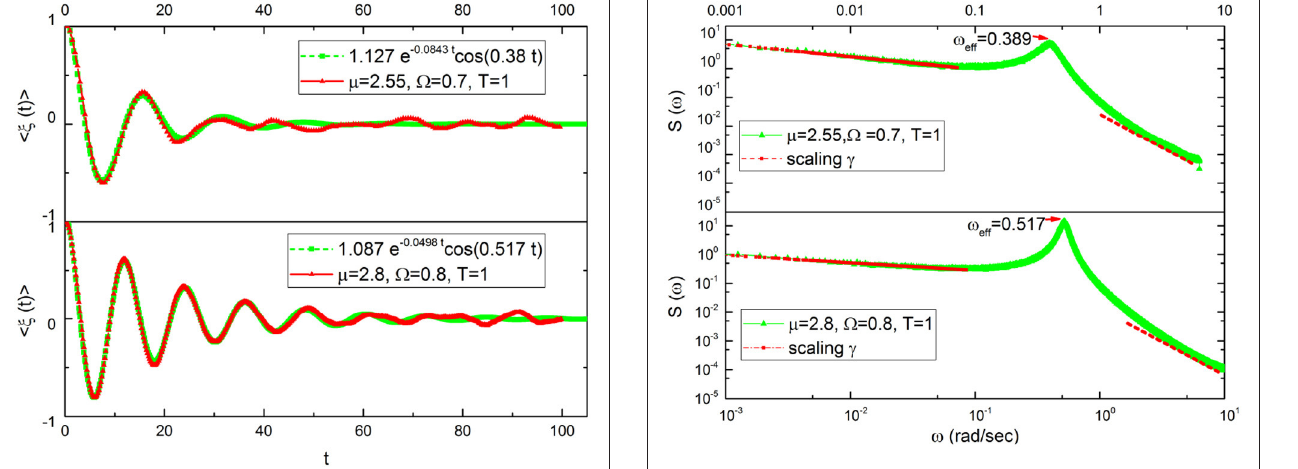
FIGURE 3 | Spectra corresponding to µ = 2.55 (top) and µ = 2.8 (bottom) .The red lines are the fitting to the numerical results. Top : The red lines at the left of periodicity bumps yield γ = 0.43 to be compared to the theoretical prediction γ = 3 − µ = 0.45. The red lines at the right of the periodicity bump correspond to the prediction γ = 2. Bottom : The red lines at the left of periodicity bumps yield γ = 0.26 to be compared to the theoretical prediction γ = 3 − µ = 0.2. The red lines at the right of the periodicity bump correspond to the prediction γ =